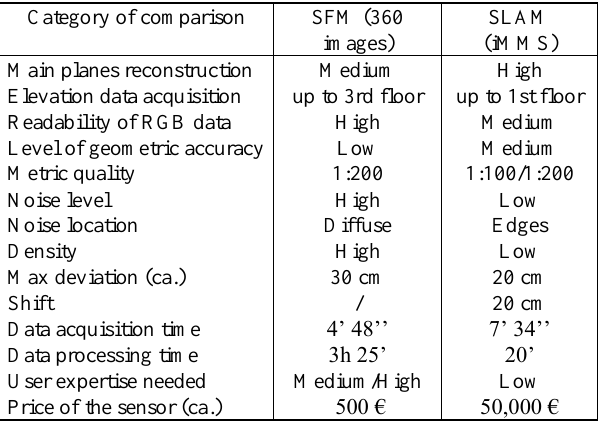
Table 4 . Comparison table between SFM (GOPRO Fusion 360) and SLAM (BLK2GO)